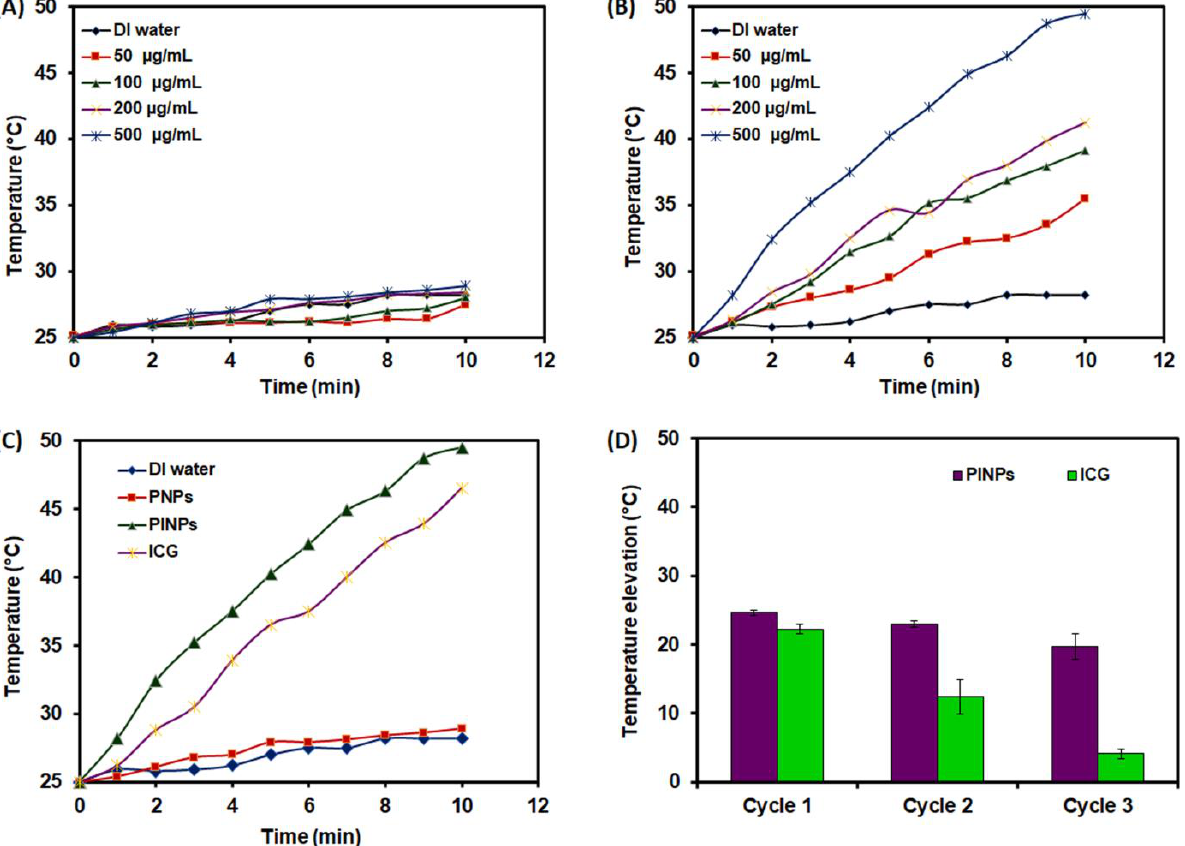
Figure 3. Photothermal effect of PNP and PINPs. ( A ) Temperature rising graphs of PNPs determined at various concentrations under NIR-808 exposure (2 W/cm 2 ) and compared against DI water. ( B ) Temperature rising graphs of PINPs determined at various concentrations under NIR-808 laser and compared against DI water. ( C ) Temperature rising graphs of DI water, PNPs, PINPs, and ICG determined at similar concentration of PNPs or ICG. ( D ) Temperature rising graphs of PINPs and ICG determined at similar ICG concentrations with three successive on/off rounds of NIR-808 exposure. Results are presented as mean ± SD in triplicate.